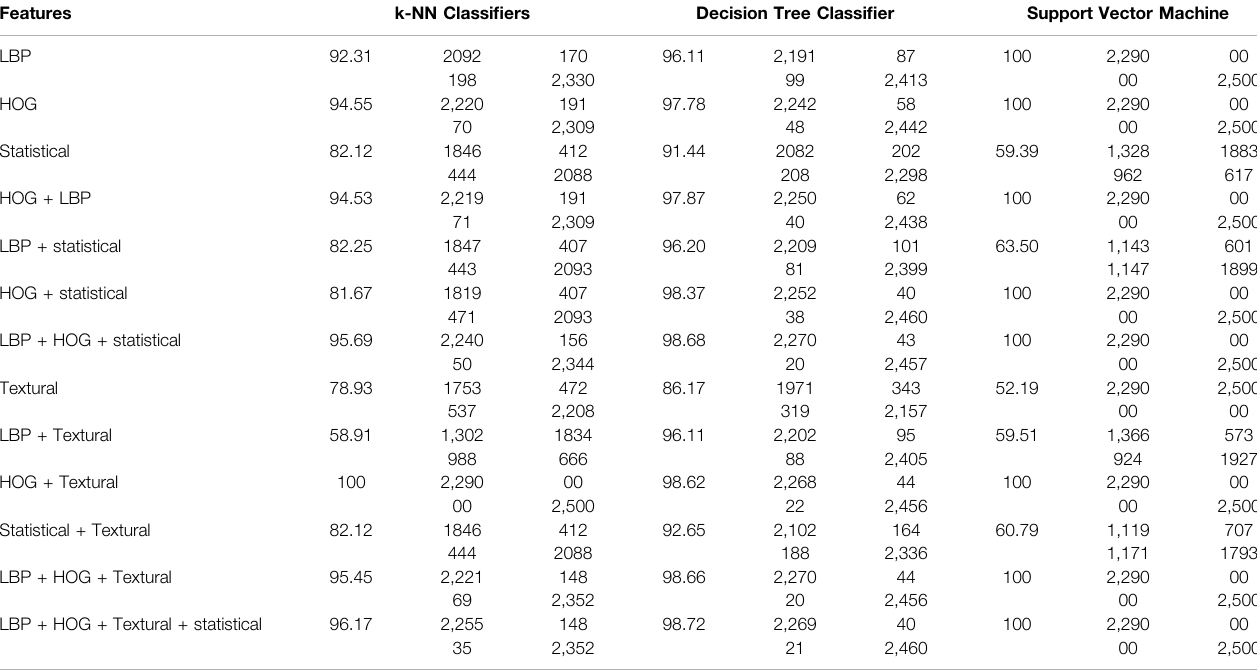
TABLE 1 | Classi fi cation accuracy of the proposed method and confusion matrix, for each of the features and fusion of features, obtained by the binary classi fi ers, namely, k-NN, decision tree and SVM.